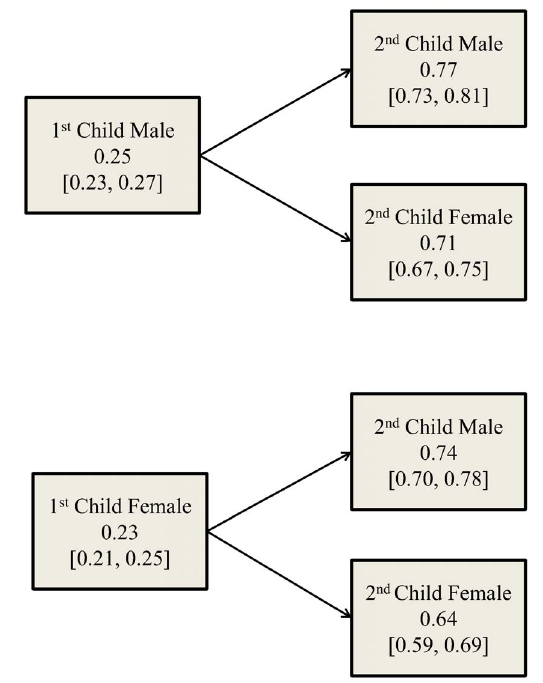
Figure 2. Predicted probabilities of receiving fresh milk, children , 60 months, NFHS-3.